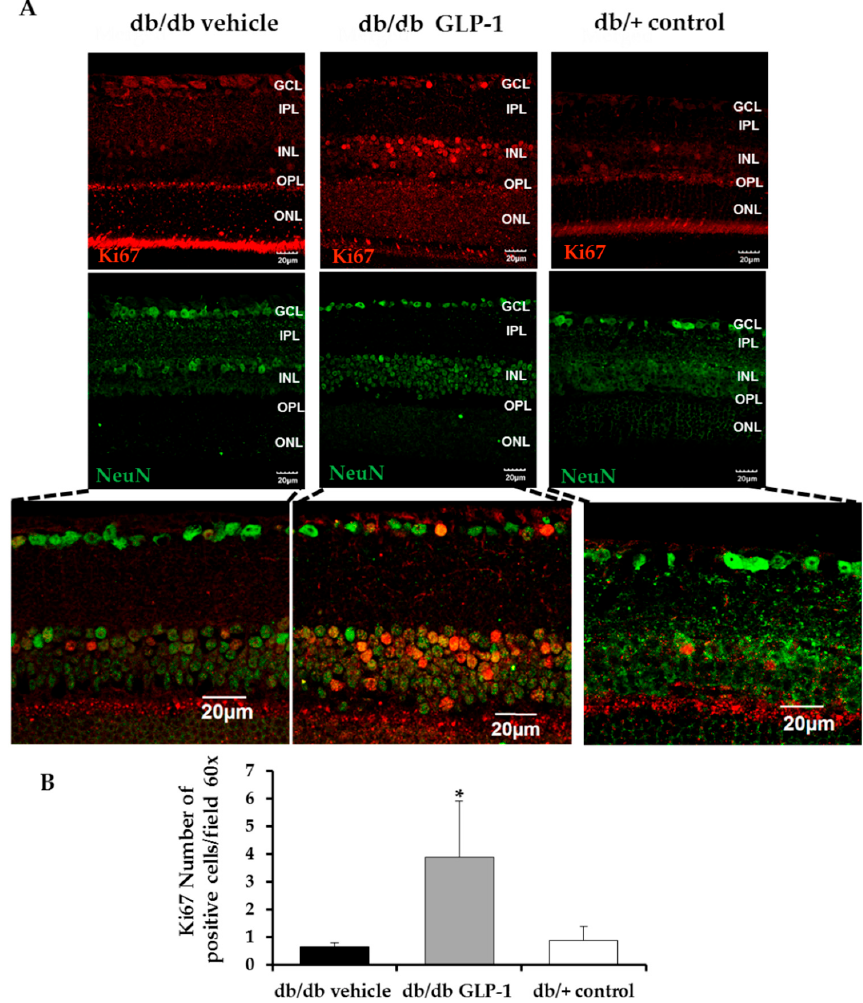
Figure 4. ( A ) Comparison of Ki67 (red) immunofluorescence colabeling with NeuN (neuron specific marker) (green) in retinas among representative samples from diabetic mice treated with vehicle or glucagon-like peptide-1 (GLP-1) eye-drops and from a non-diabetic mouse. Scale bars, 20 µm. n = 4; ( B ) Quantification of Ki67-positive cells per × 60 field. n = 4 mice per groups; * p < 0.05 db/db GLP-1 in comparison with other groups; GCL, ganglion cell layer; INL, inner nuclear layer; IPL, inner plexiform layer; ONL, outer nuclear layer; OPL, outer plexiform layer.